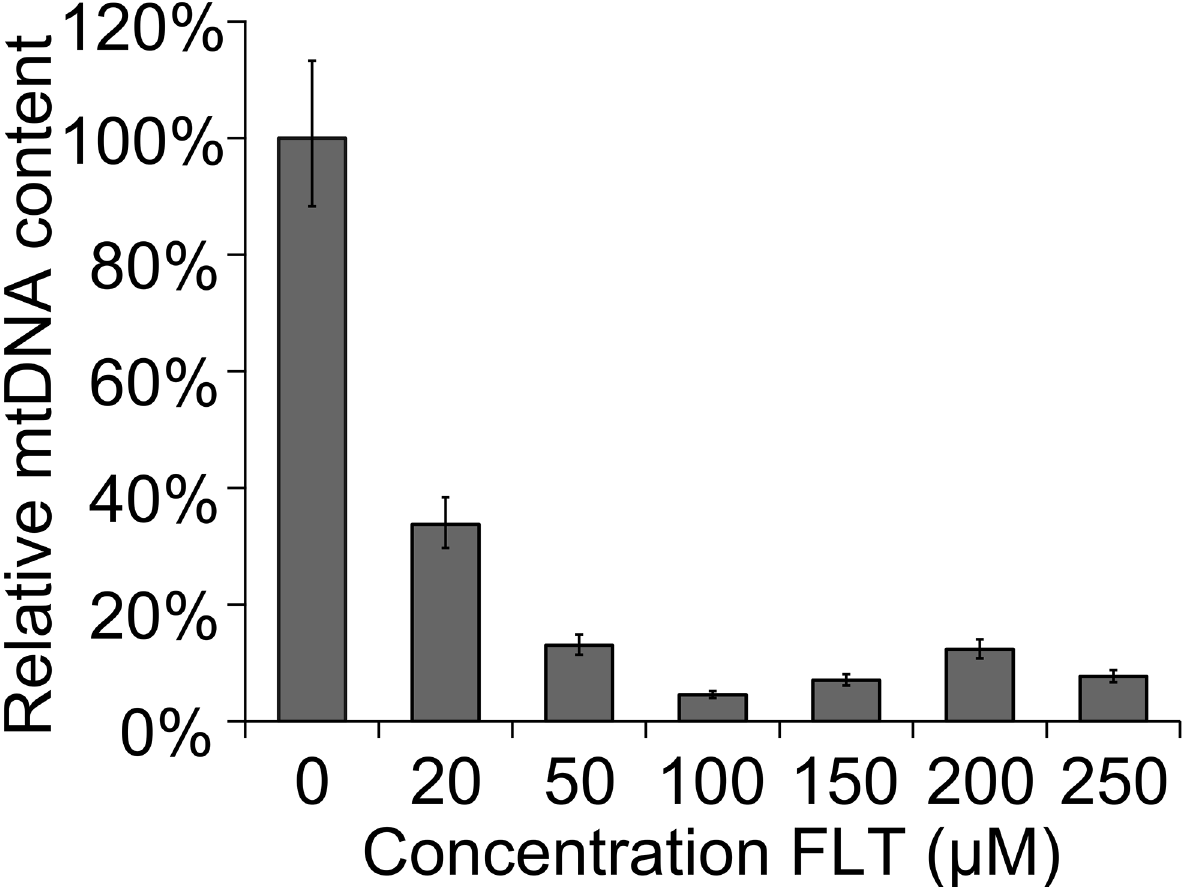
Fig 1. Concentration dependent decrease of mtDNA. Synchronised L1 worms were put on a plate with FLT and experiments were performed after 72hrs of continuous exposure. In FLT exposed animals, the reduction of mtDNA is concentration dependent. Error bars represent 95% CI (df = 16). Significance was determined using a two-tailed student ’ s T test assuming unequal variances. P-value was < 0.001 for all reported concentrations.